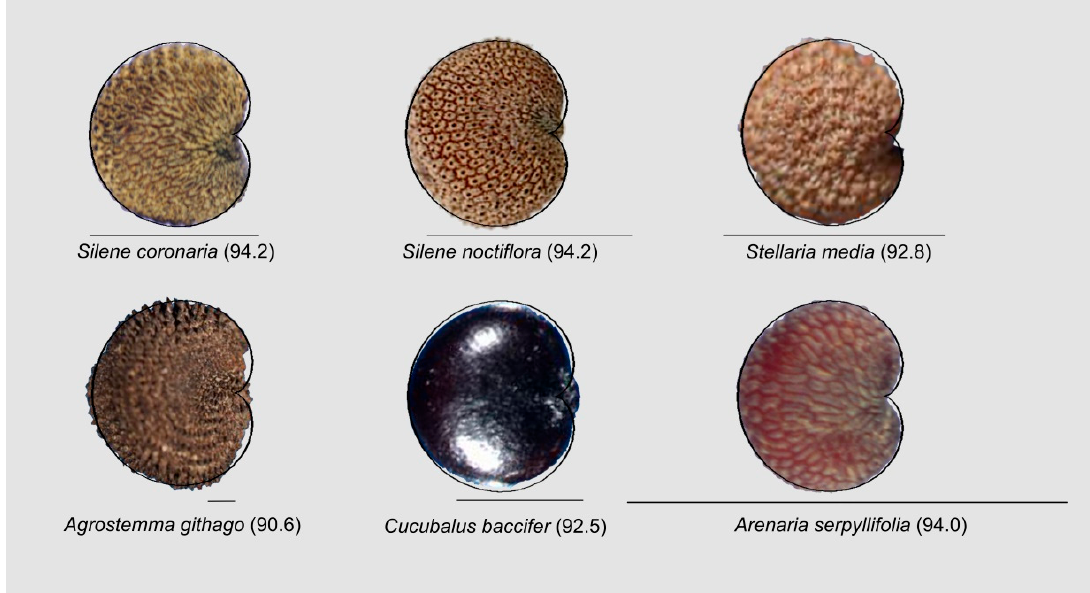
Figure 14. The cardioid is a model for seed shape description and quantification in species of Caryophyllales (Caryophyllaceae). The values indicated correspond to J index in the images shown and do not represent mean values for each particular species. Bar equals 0.5 mm.